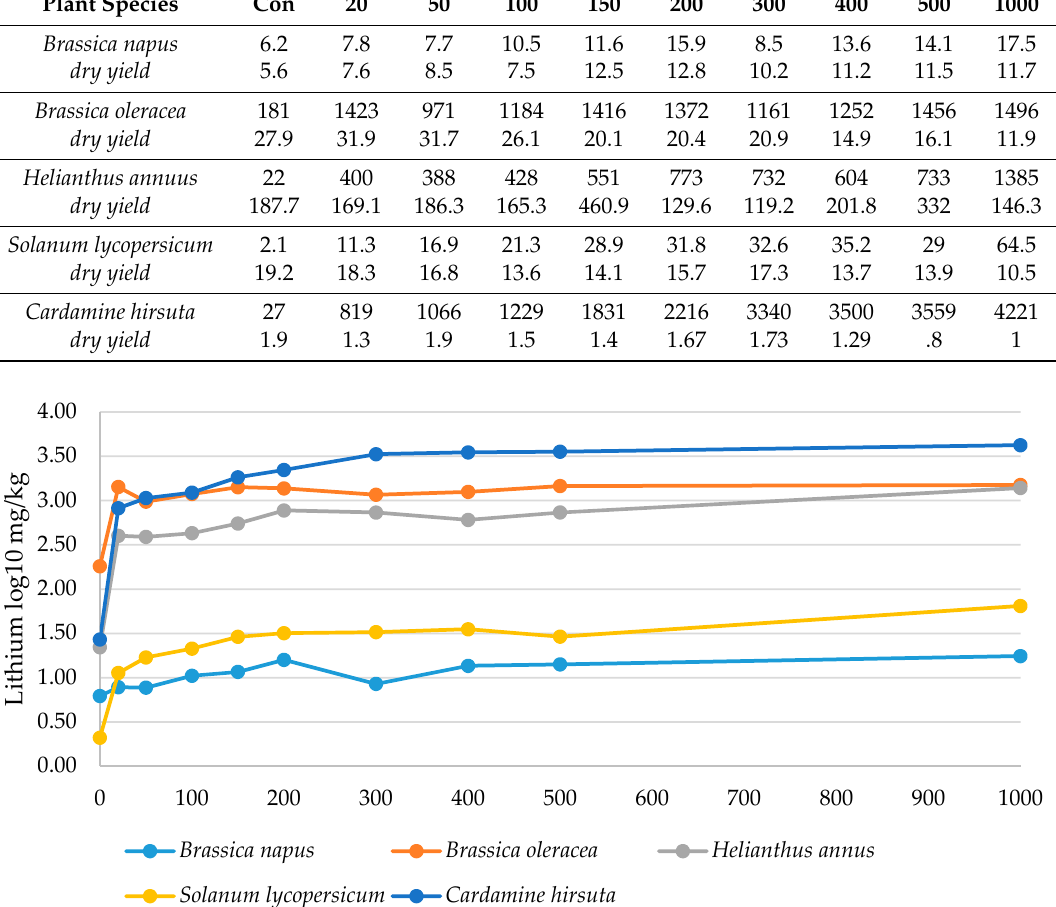
Table 3. x ̅ Li concentrations in leaves of 5 plant species at each level of Li soil amendment in mg/kg and x ̅ plant dry matter yields in grams. (Con = Control group) (starting, n = 10 plants per group) (Total number of plants at end of trial 1 = 468).